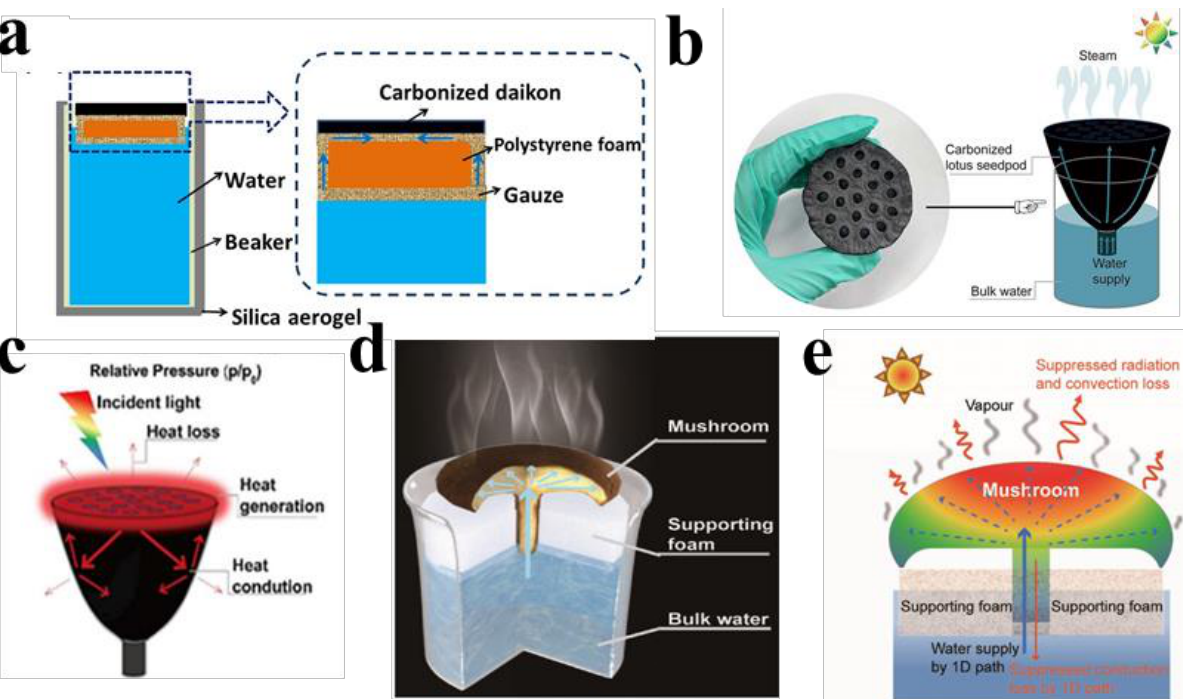
Figure 9: Thermal management of natural biological materials (a) schematics of the carbonized daikon device [90]; (b) top view and (c) heat management of carbonized lotus seedpods [91]; (d) the mushroom-based device and (e) the heat behavior